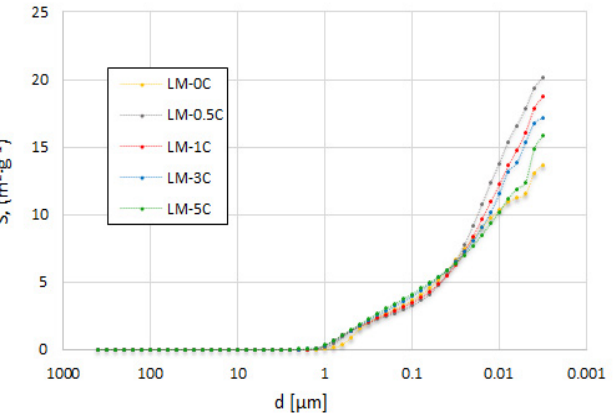
Figure 5. Total pore surface versus pore diameter for tested lime-metakaolin pastes.